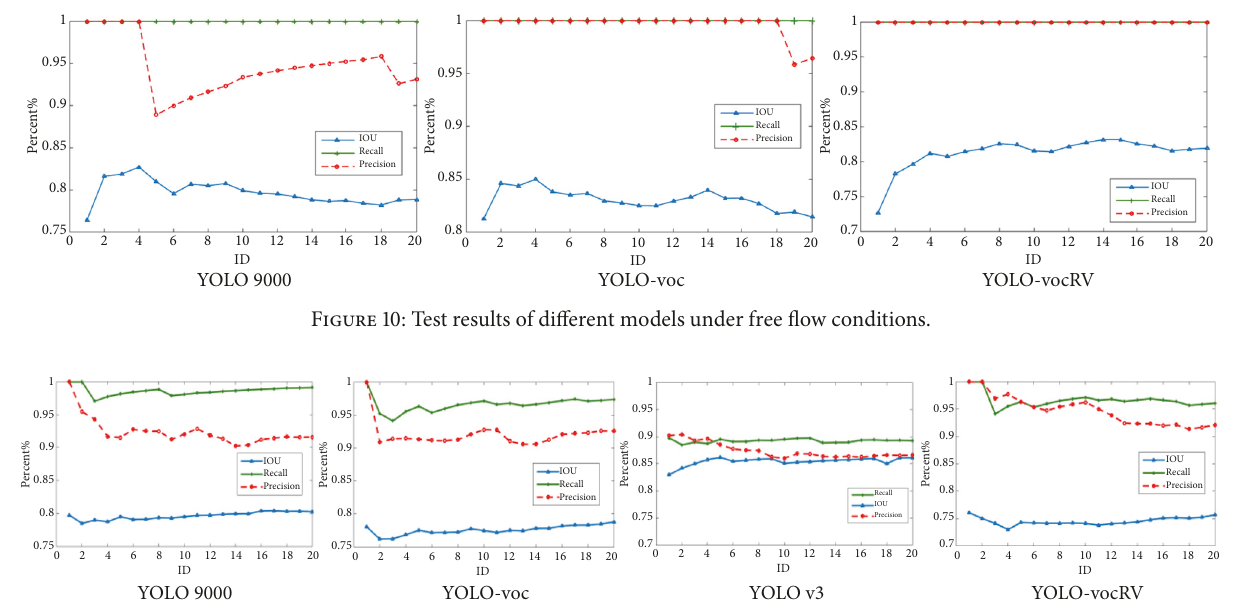
Figure 11: Test results of different models under blocking flow